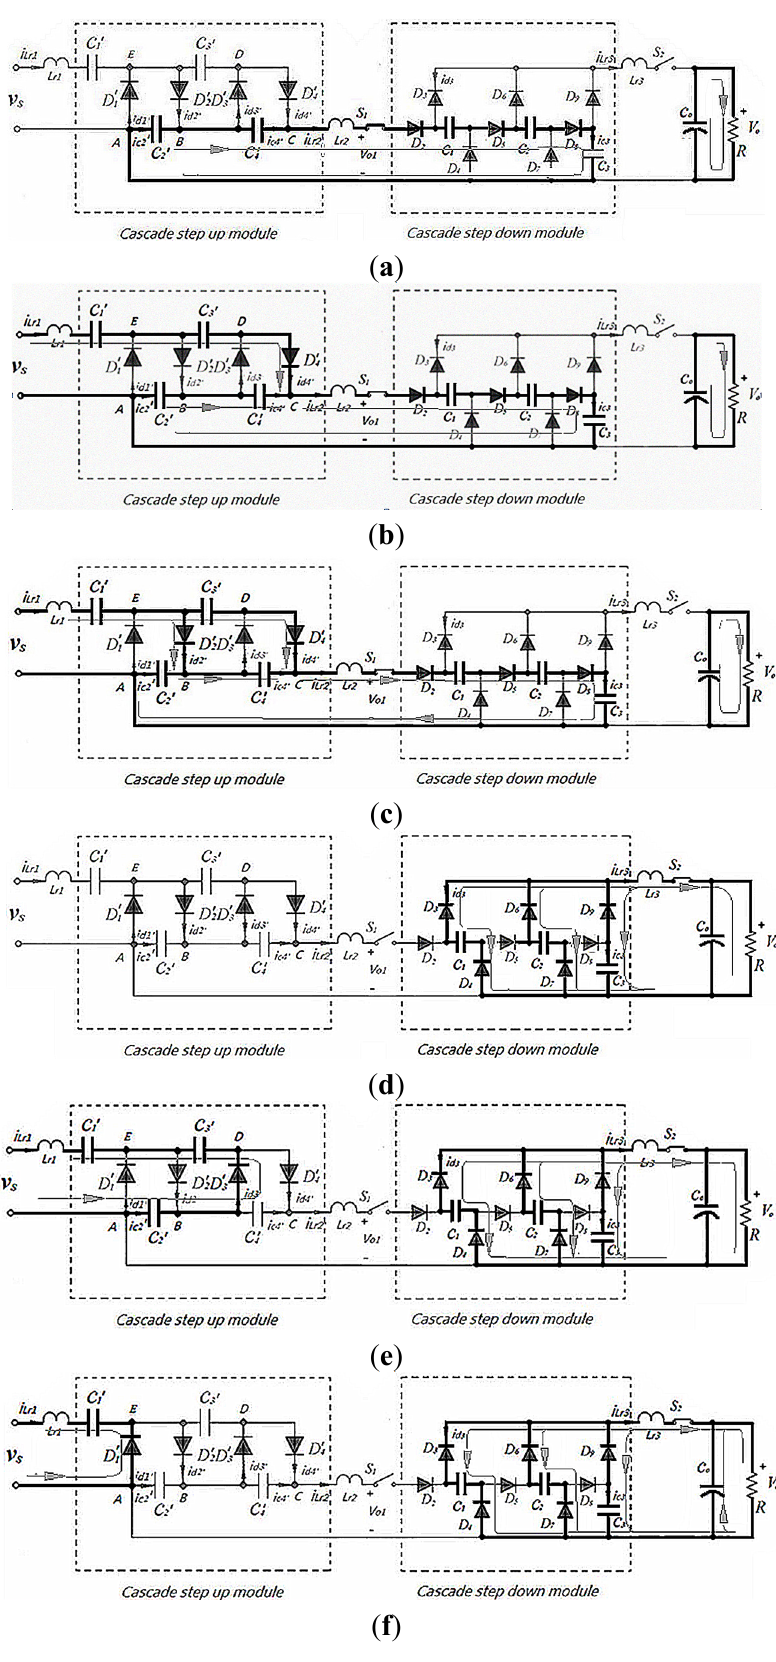
Figure 6. The detailed operation states of the proposed circuit: ( a ) State 1; ( b ) State 2; ( c ) State 3; ( d ) State 4; ( e ) State 5; and ( f ) State